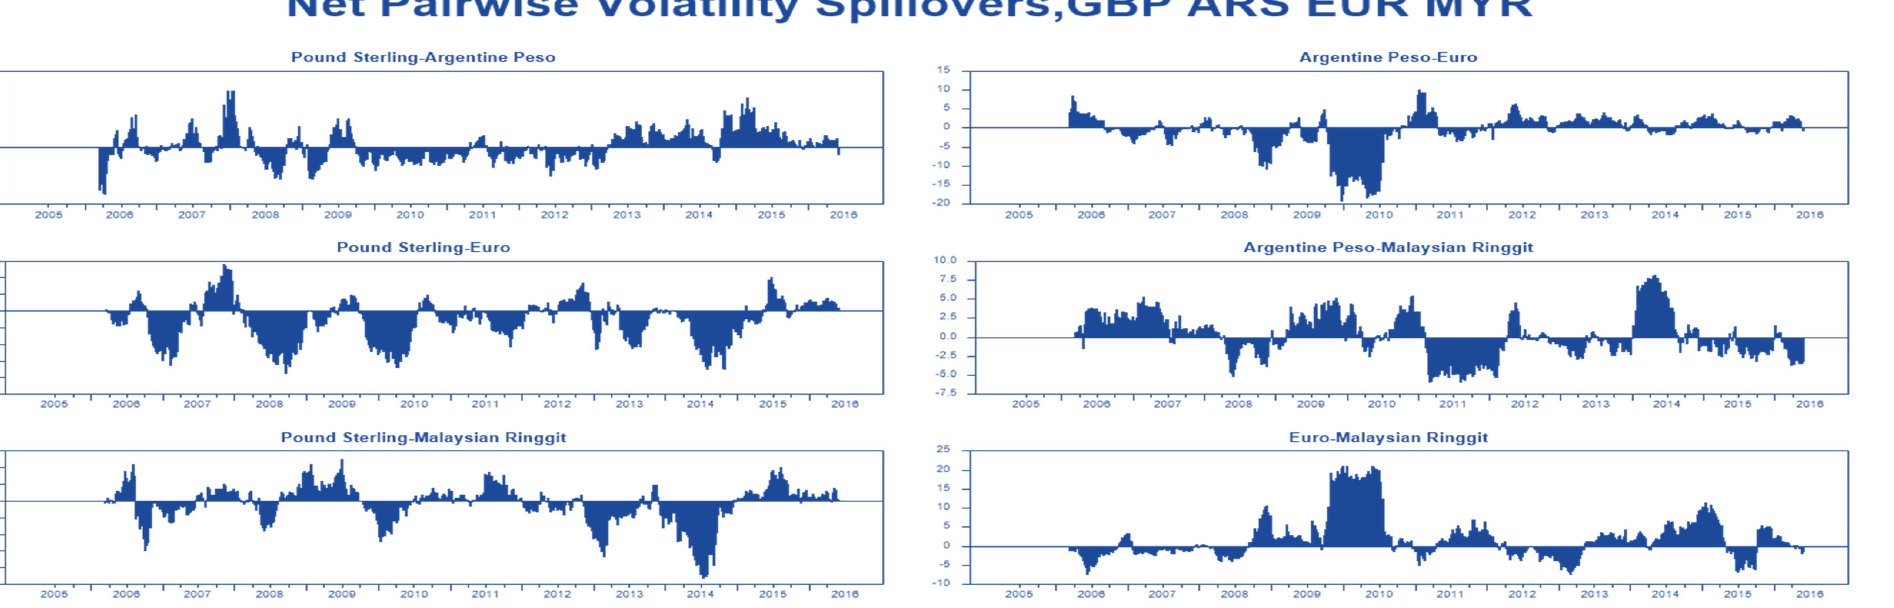
Figure 9. This figure shows the net pairwise volatility spillovers between developed and developing countries. In particular, the net pairwise volatility spillovers from/to the Pound Sterling (GBP), Argentine Peso (ARS), Euro (EUR), and the Malaysian Ringgit (MYR).